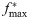
Physiological model for glycoprotein quality control outperforms other models.(A) Schematic of cyclic and non-cyclic models. The physiological model corresponds to the consensus description of the glycoprotein quality control pathway. (B) Ratios of folding efficiency fmax* comparing performance of all models to the physiological model. Curve color indicates the model being compared, with solid lines for mf = 0.001 and dashed lines for mf = 0.4. For all curves, kf = 1.